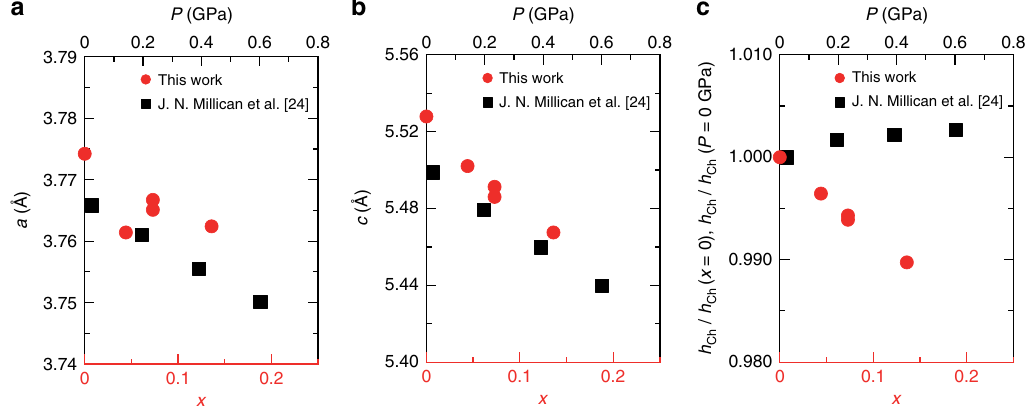
Fig. 4 Comparisons between physical pressure and isovalent substitution effects on the structural parameters. a , b Lattice constants a ( a ) and c ( b ) as a function of S content x in the present single crystals of FeSe 1 − x S x (red circles, bottom axis), compared with those as a function of pressure reported for polycrystals of FeSe in ref. 24 (black squares, top axis). c Chalcogen height h Ch normalized by the initial values as a function of x (red circles, bottom axis) and pressure (black squares, top axis) 24 . The numerical values of these parameters are listed in Supplementary Table 1